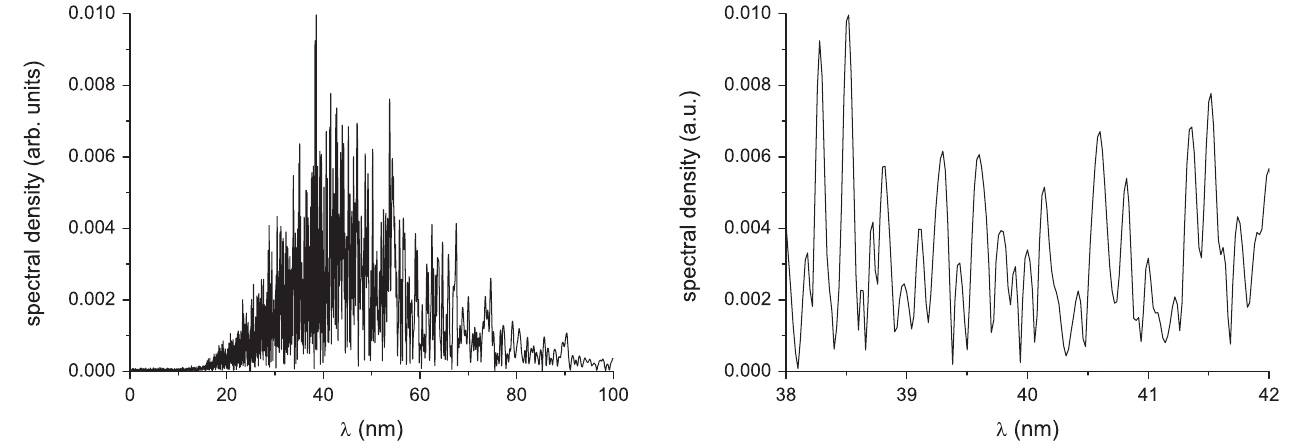
FIG. 7. Spectrum of the modulated electron current (modulus of the bunch form factor) and its enlarged fraction after the third amplification cascade. The calculations were performed with LOSCA